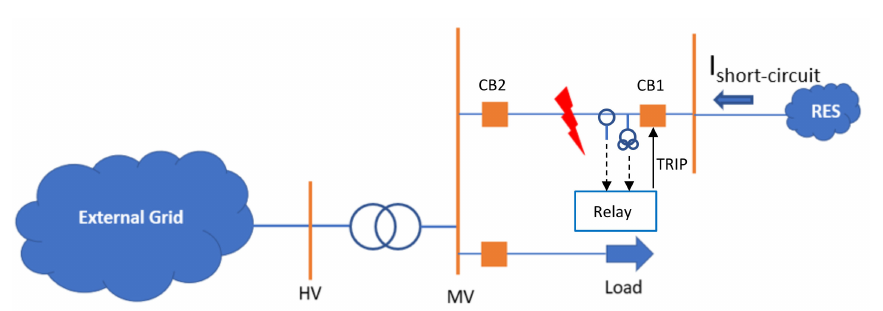
Figure 9. Benchmark distribution grid used to analyse relay